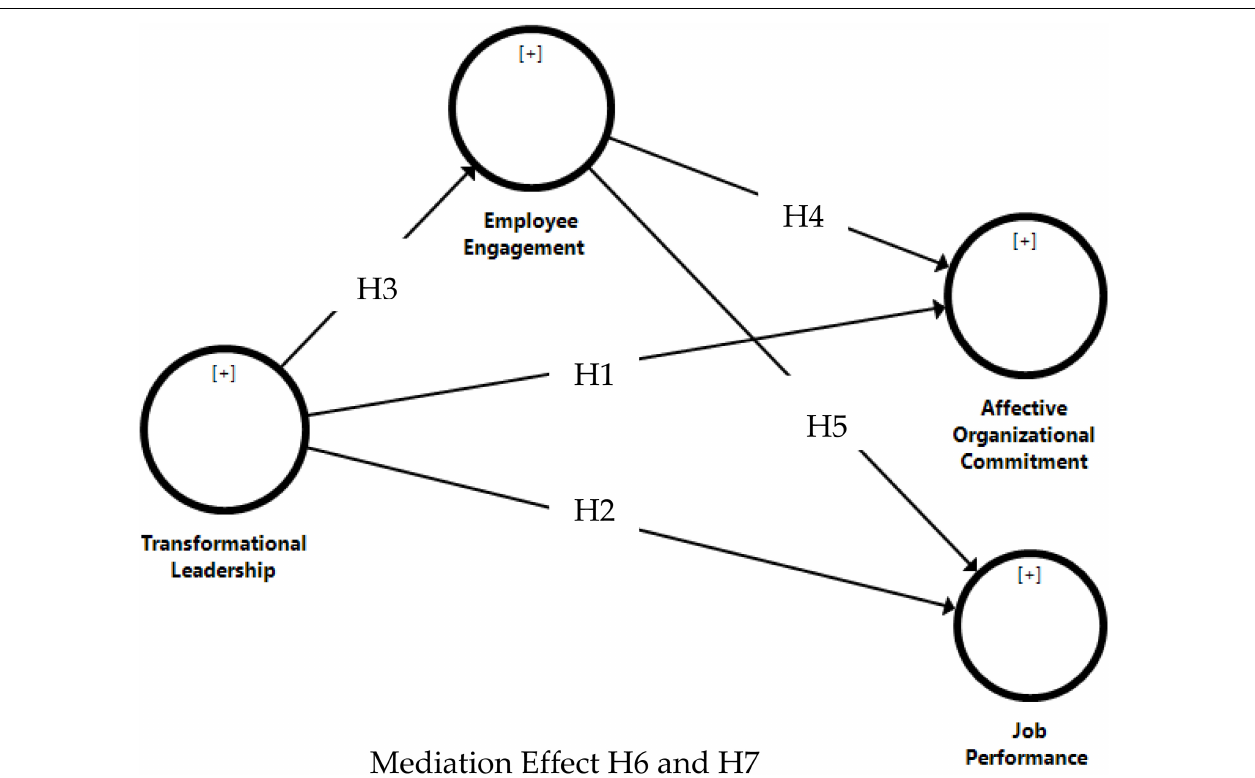
FIGURE 1 | Conceptual